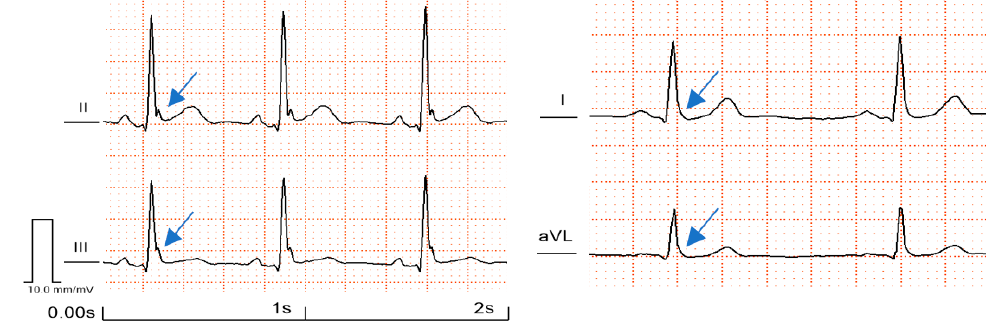
Figure 1. Different manifestations and localization of J-waves on the surface ECG. ERP with notching morphology in the inferior leads (on the left side). ERP with slurring morphology in the lateral leads (on the right side). The J-waves are marked with arrows. ECGs from the authors’ own collection.